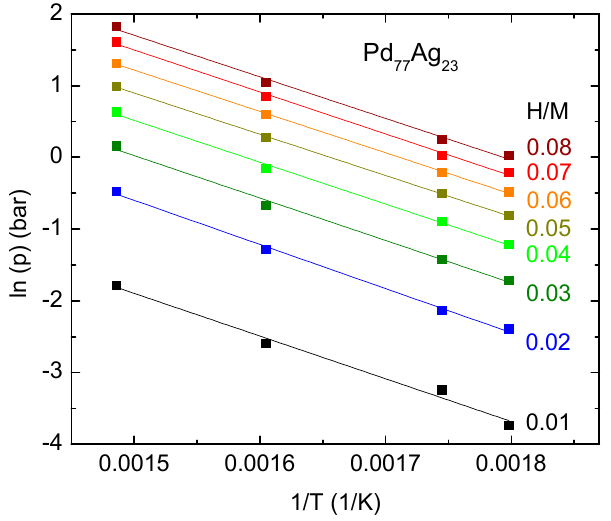
Figure 4. Van’t Hoff plot for Pd 77 Ag 23 at a fixed H / M (the number of hydrogen atoms per atom of metal) in the low concentration region and best fit lines to calculate the hydrogenation enthalpy.